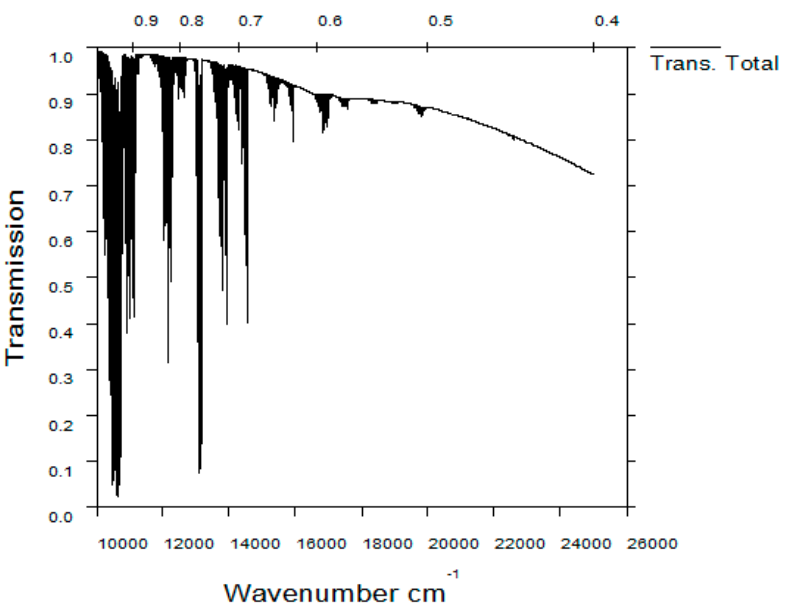
Figure 4. The atmospheric transmittance per wavelength in the spectral range of 400 nm–1000 nm. Table 1. Main parameters of MODTRAN used to calculate transmittance.